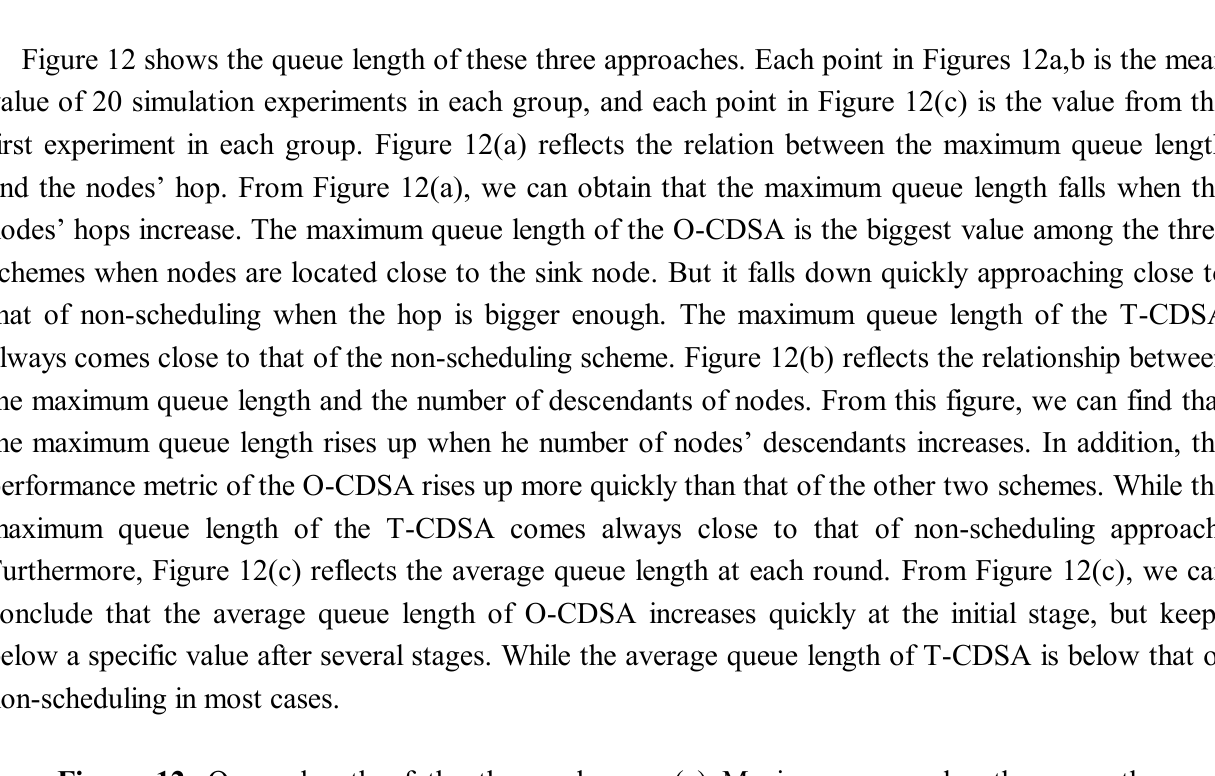
Figure 12. Queue length of the three schemes: (a) Maximum queue length versus the nodes’ hop. (b) Maximum queue length versus the number of descendants. (c) Average queue length at each